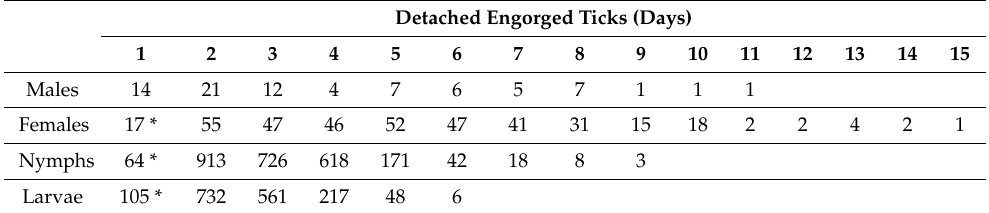
Table 4. Times spent on hosts by various Ixodes ricinus developmental stages (in